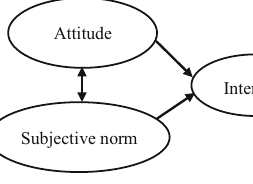
Fig. 1 Theory of reasoned action